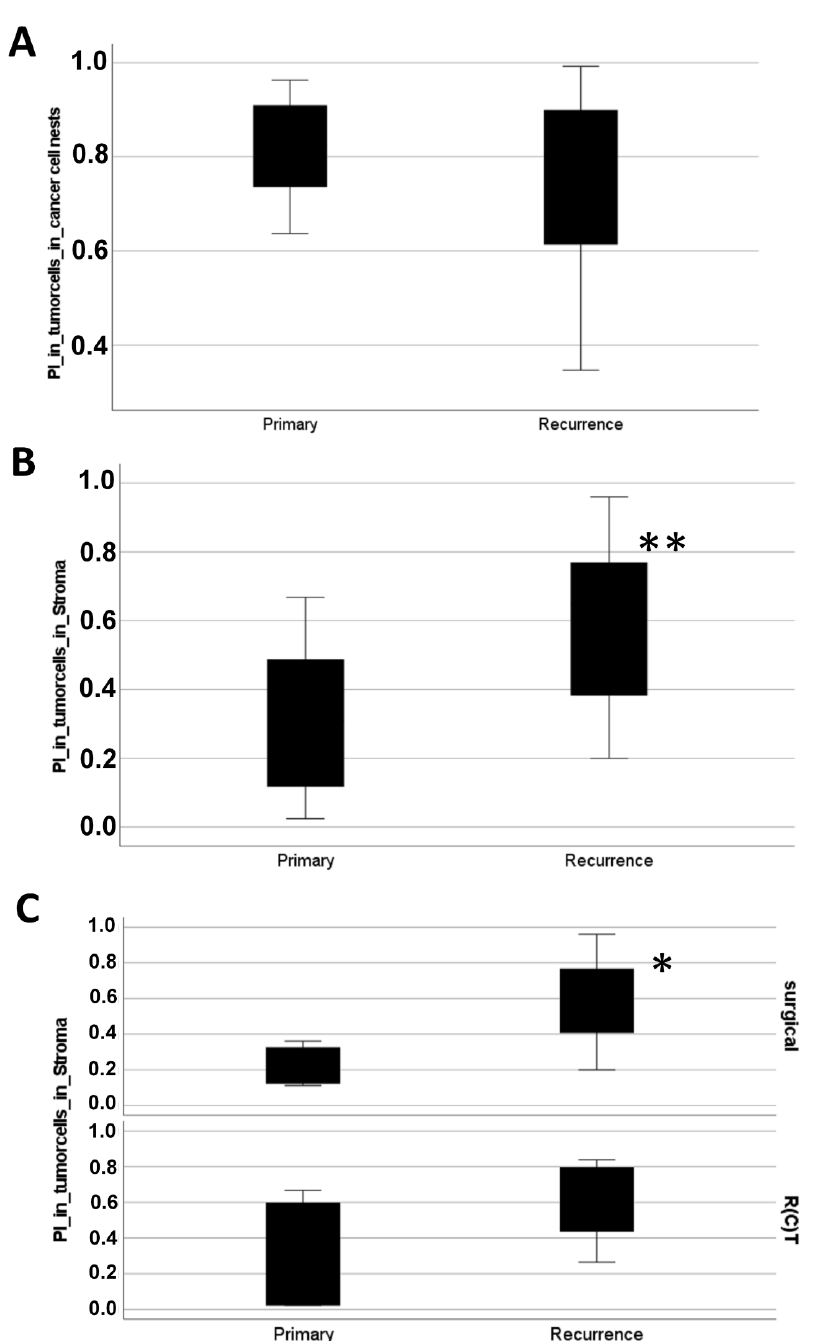
Figure 2. Mann–Whitney U-test was performed to compare the proliferation index (PI, relative abundance of Ki-67-positive cells) of tumor cells in cancer cell nests ( A ) and tumor cells found in stroma areas ( B ). ( A ) For comparison of the PI in tumor cells in cancer cell nests 16 regions of therapy naive primary tumors and 24 regions of recurrence tumors were available. No significant difference in the PI in the tumor cell nests was found ( p = 0.576, at 95% confidence interval n = 40). ( B ) The PI in tumor cells embedded in stroma (disseminating tumor cells) was significantly higher in